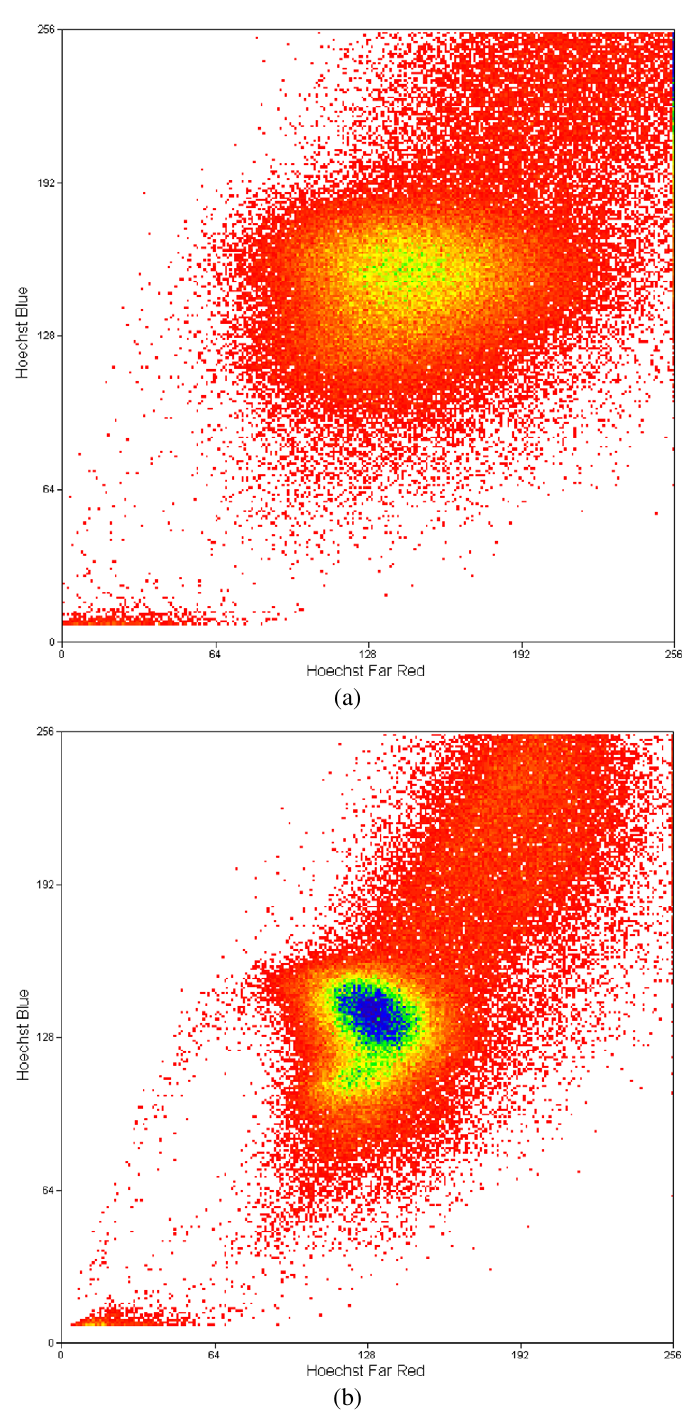
Fig. 3. Ho342 SP analysis of unpurified human BM on a MoFlo R (cid:1) cell sorter equipped with an Enterprise II water-cooled ion laser emitting at 351 nm. Since the Red signal is lower in intensity by default (because of the intrinsic physical properties of this dye), resolution in the Red emission is not as good as Blue and relatively higher laser power is needed. Effect of UV laser power settings on the resolution of the SP: 1 mW (a) and 12 mW